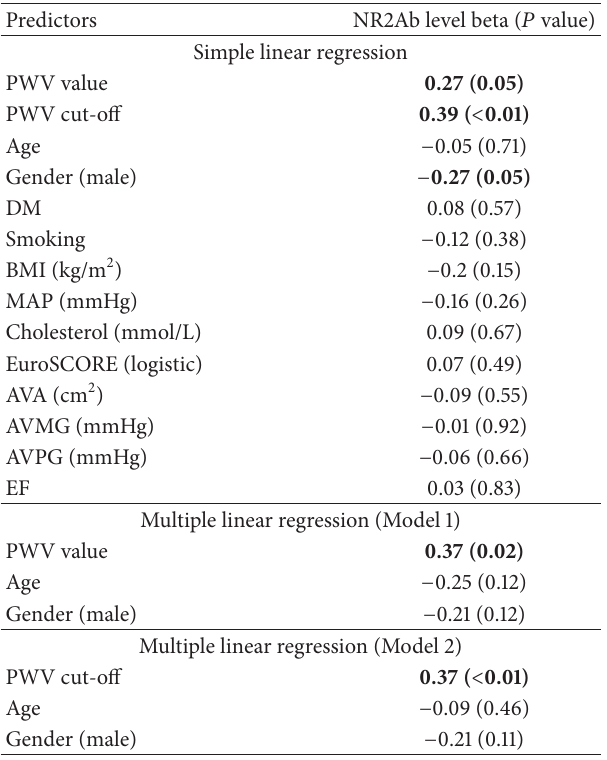
Table 2: Simple and multiple linear regression analysis to identify variables that independently predict NR2Ab